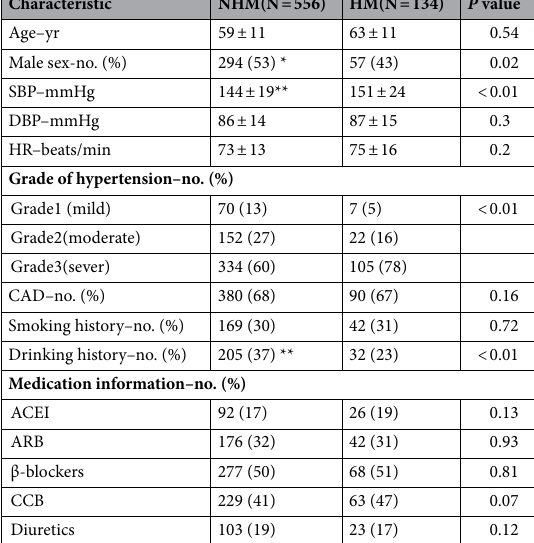
Table 1. Comparison of patients’ general data. The data are presented as mean ± SD for continuous variables and n for categorical variables. SBP Systolic blood pressure, DBP Diastolic blood pressure, HR Heart rate, CAD Coronary atherosclerotic heart disease, ACEI Angiotensin converting enzyme inhibitor, ARB Angiotensin receptor blocker, CCB Calcium channel blocker. *significantly different from the HM group ( P < 0.05) **significantly different from the HM group ( P <